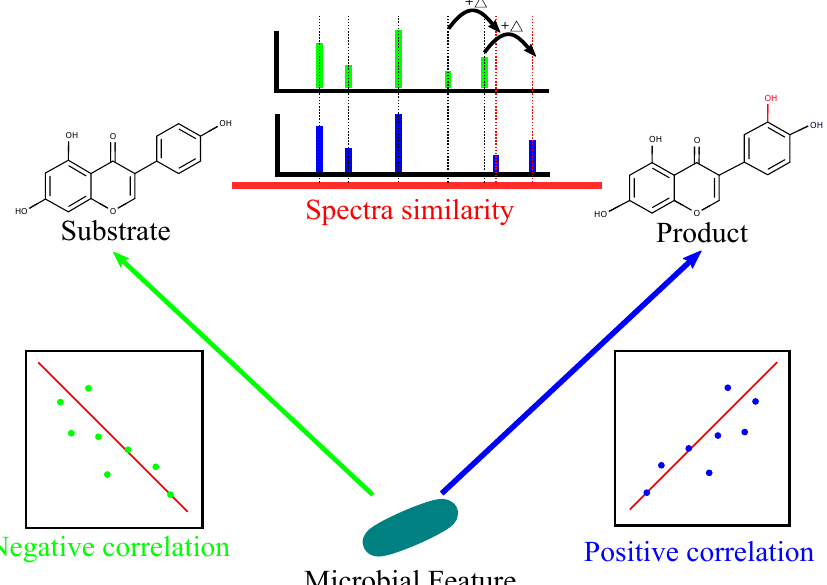
Figure 4. Candidate biotransformations were identified as triplets of microbial features, substrates, and products where there was (i) a positive correlation between the microbial feature and the product, (ii) a negative correlation between the microbial feature and the substrate, and (iii) an edge in the molecular network between the substrate and the